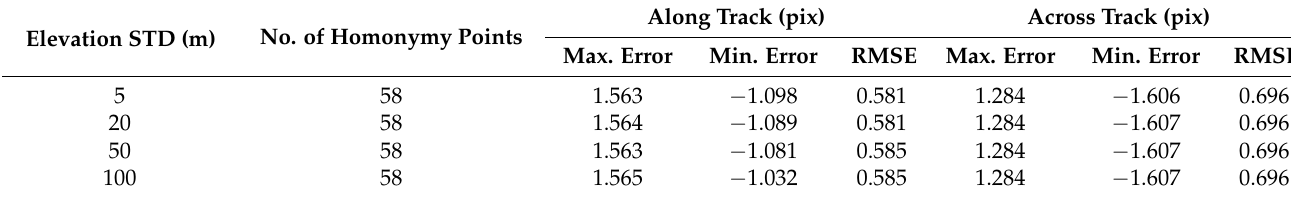
Table 12. Relative orientation residual of EA-unstable-2 (left-middle